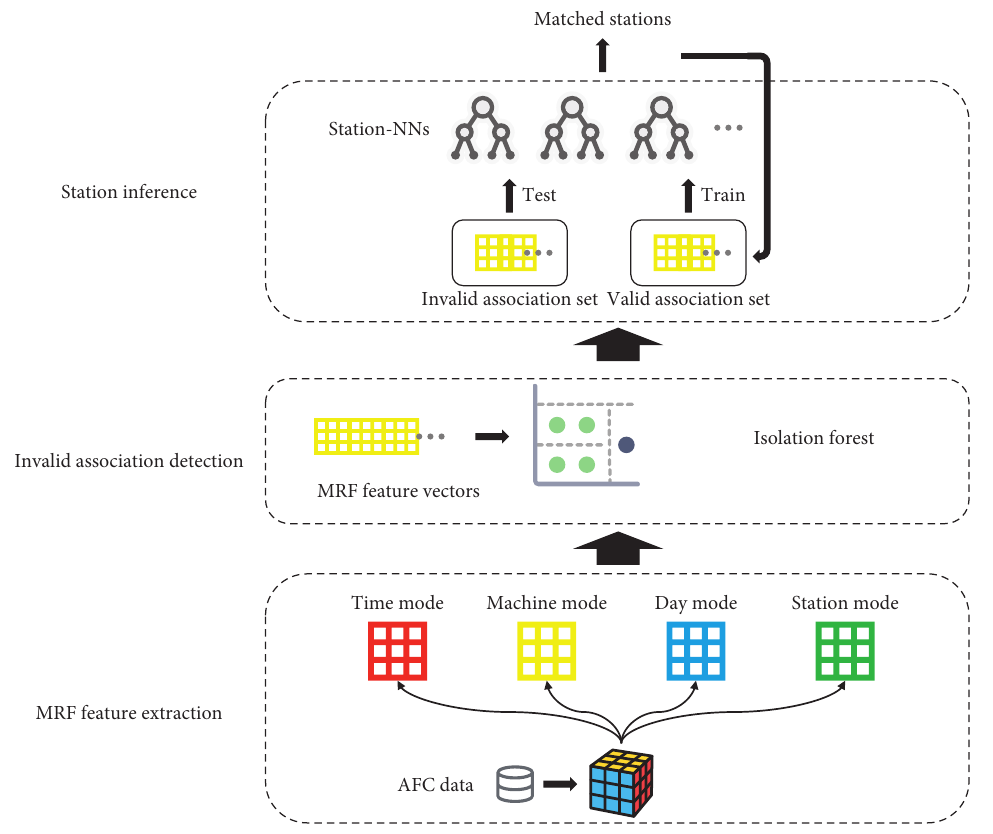
Figure 3: Overview of the proposed